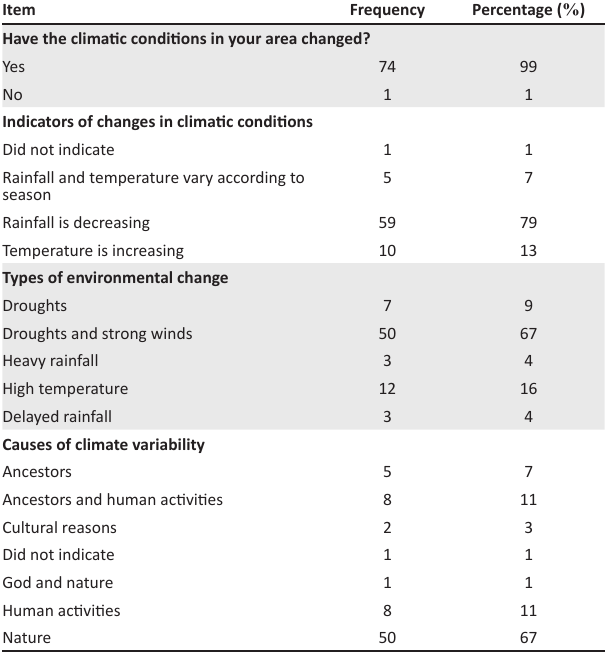
TABLE 3: Farmers’ perceptions and understanding of climate